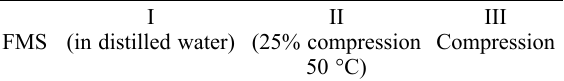
Table 1. Results of tests on FMS using tensile-compression cycling